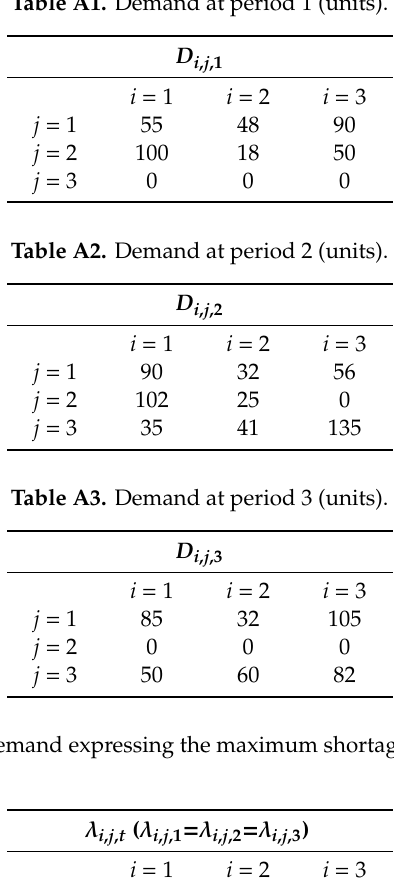
Table A1. Demand at period 1 (units).